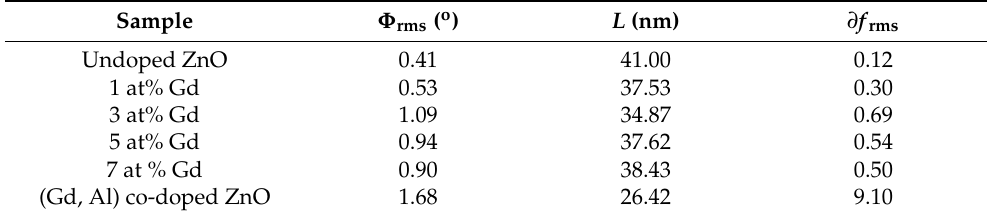
Table 3. The magnetic properties of undoped ZnO, (1, 3, 5, 7 at%) Gd-doped ZnO, and 3 at% (Gd, Al) co-doped ZnO